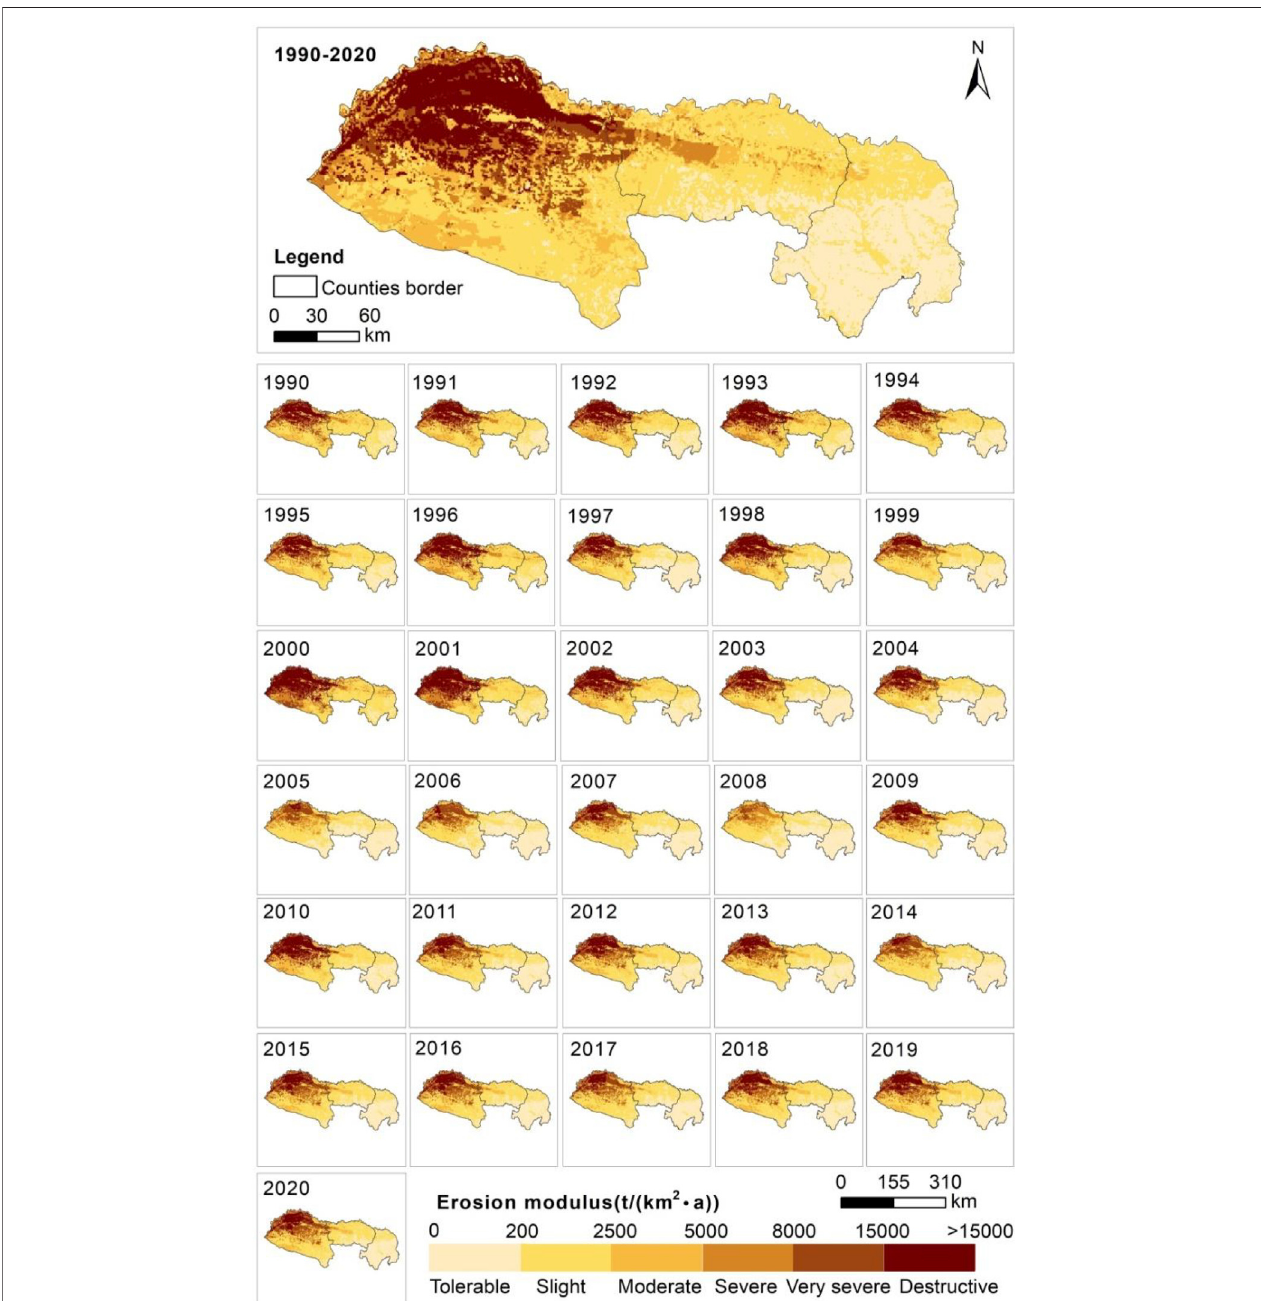
FIGURE 7 | Spatial distributions of soil – wind erosion in the Kubuqi Desert region during 1990 – 2020.